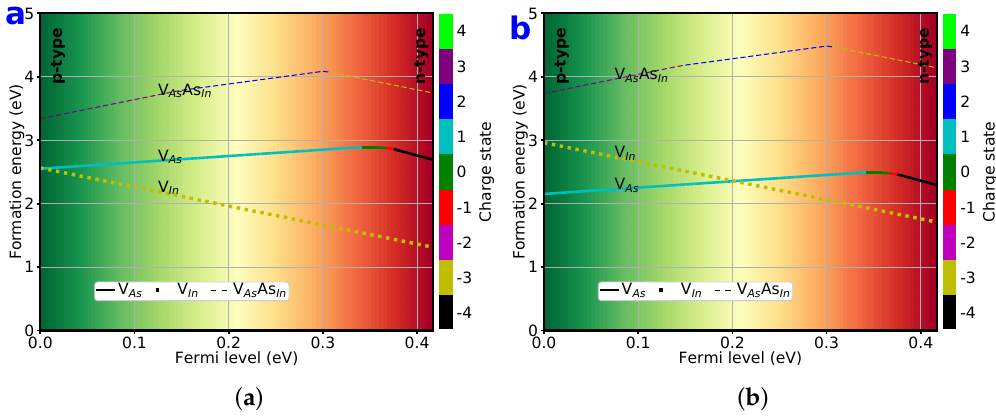
Figure 7. Formation energies as functions of E F in the ( a ) As-rich and ( b ) In-rich environment for two vacancy-type point defects in zb -InAs with all possible charge states from − 4 to + 4 marked with different colors.